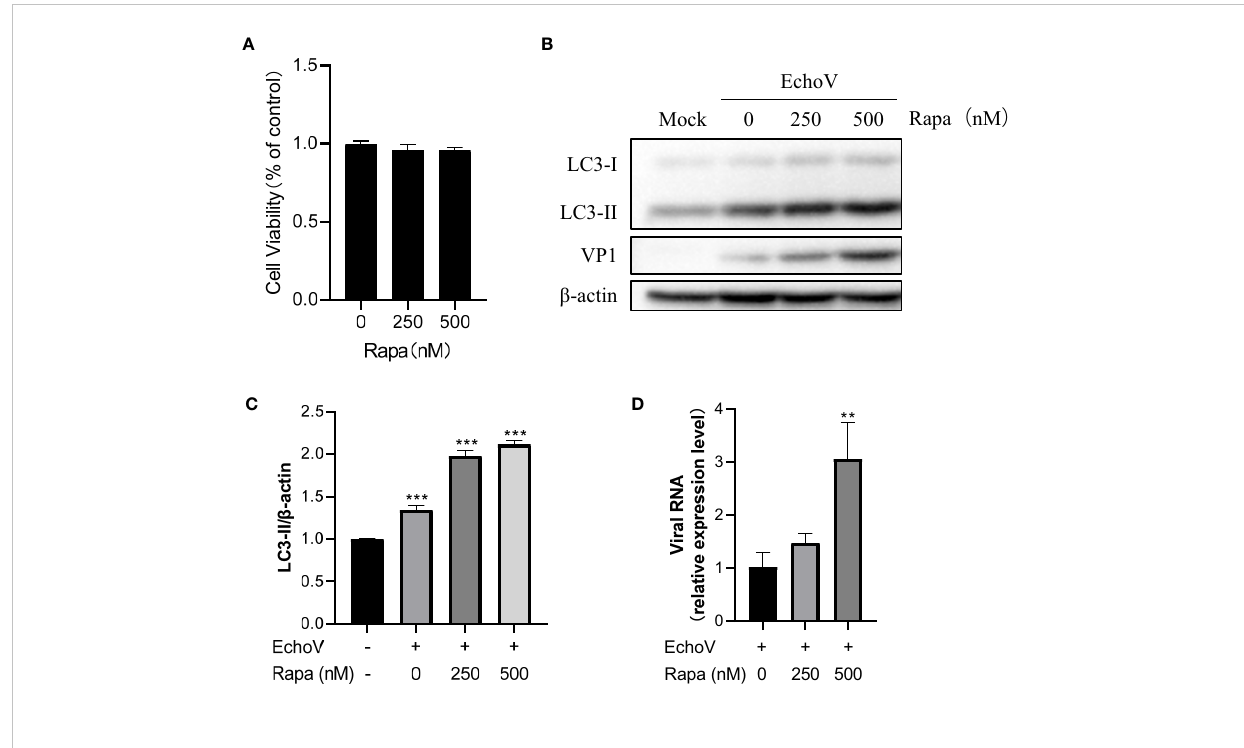
FIGURE 6 Induction of autophagy promotes Echovirus replication. RD cells were infected or not (Mock) with echovirus 11 at 0.1 MOI for 1.5 h and then untreated (Echo) or treated with rapamycin (Rapa) at indicated concentrations for 16 h. Cells were then harvested. (A) Cell counting kit-8 (CCK8) assay was performed to examine the cytotoxicity of rapamycin to RD cells. (B) Intracellular LC3 and viral VP1 proteins were detected via western blotting. b -actin served as a loading control. This result is representative of three independent experiments. The relative band intensities of detected proteins were calculated using ImageJ from NIH, and the result was represented as the ratio of LC3-II to b -actin (C) . (D) Total RNA was extracted from cells and subjected to a quantitative reverse transcription-polymerase chain reaction (qRT-PCR) to detect viral RNA. A one-way ANOVA was used to determine statistically signi fi cant differences in multiple comparisons. ** P <0.01; *** P